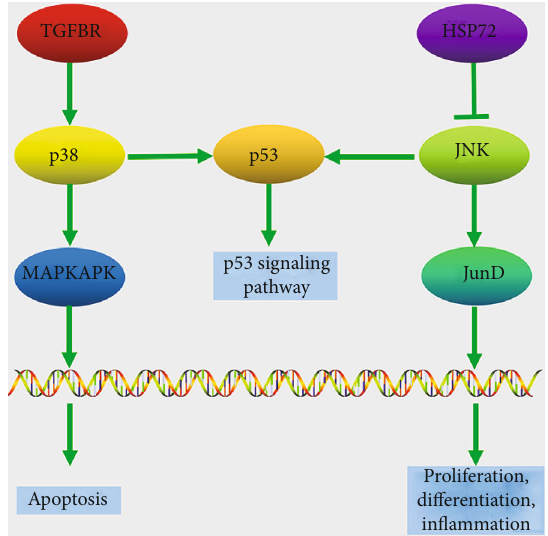
Figure 4: The part of the MAKP signaling pathway related to the common DEGs. MAPKAPK3, HSPA2, TGFBR1, and p53 signaling pathways were involved, resulting in apoptosis, proliferation, di ff erentiation, and in fl